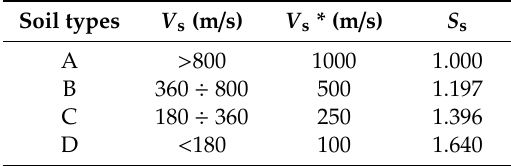
Table 1. The di ff erent shear wave velocity V S adopted for the di ff erent soil types analyzed and the corresponding stratigraphic amplification factor S S provided by